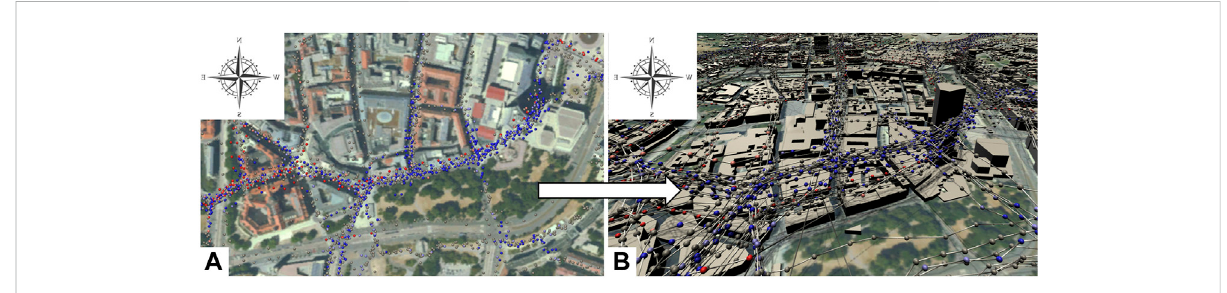
FIGURE 8 Displayofthedaytimeinthez-axistoidentifytemporalandspatialpatternsofenvironmentalpollution(herePM2.5). (A) in2Dand (B) withspace time cube visualisation.